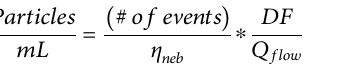
Frontiers in Toxicology |